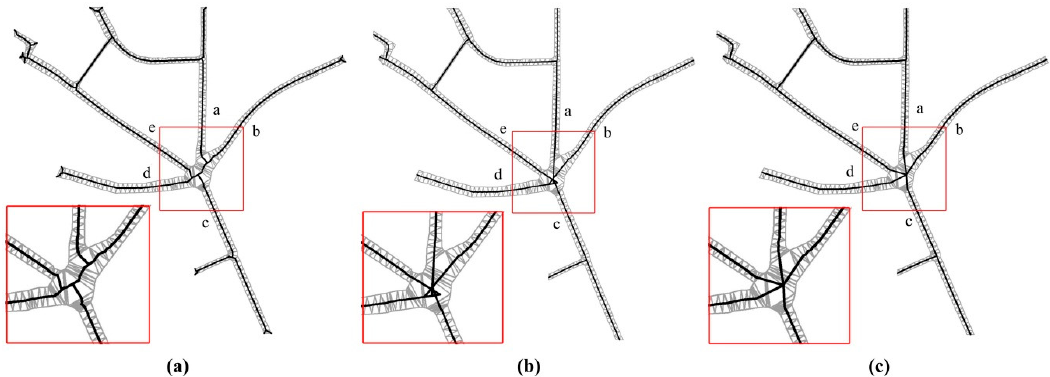
Figure 16. Case 2: Branch aggregation region with no consistent direction skeleton: ( a ) original skeleton lines, ( b ) split line extracted based on branch skeleton line extension and ( c ) split line extracted by fitting all the nodes to the geometric center.